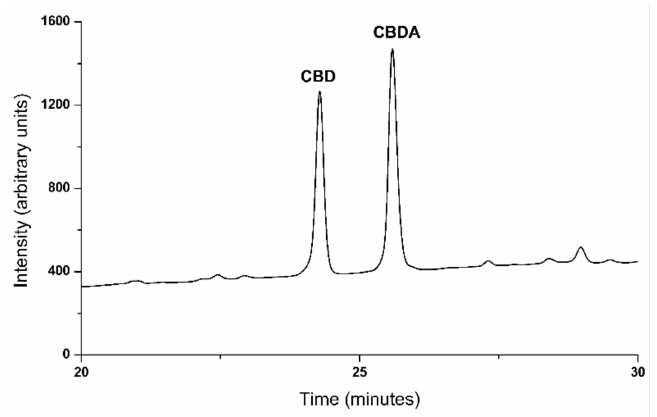
Figure 3. Representative HPLC chromatogram for crude extracted hemp oil. CBD: cannabidiol, CBDA: cannabidiolic